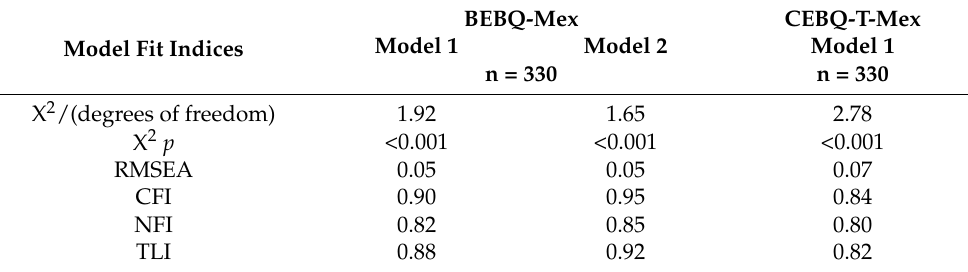
Table 4. Confirmatory factor analysis and model fit indices of the BEBQ-Mex (n = 330) and the CEBQ-T-Mex (n =